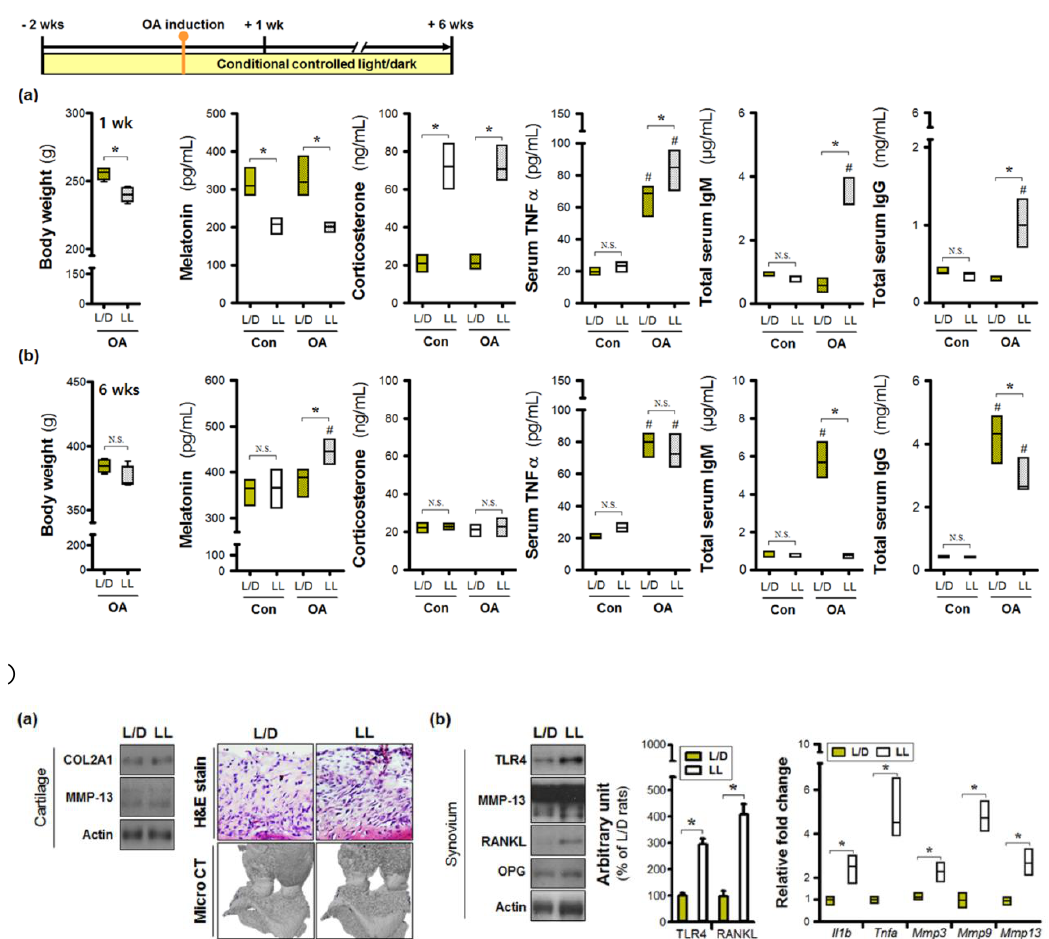
Figure 1. Constant-light-induced hormonal changes exacerbate synovial inflammation in the osteoarthritic joint. Di ff erent light / dark cycles were applied to osteoarthritic rats for 6 weeks. ( A ) Di ff erences in hormones levels (melatonin, corticosterone), immunoglobulins (IgM, IgG), and TNF α in serum, as well as overall body weight, were observed at ( a ) 1 week and ( b ) 6 weeks after osteoarthritic induction. ( B ) Di ff erences in disease outcomes associated with lighting conditions were limited to ( a ) cartilage destruction and were not observed in ( b ) synovial inflammation. Gene expression levels are shown relative to the L / D group. * p < 0.05 L / D vs. LL; # p < 0.05 Con vs. OA. N.S. not